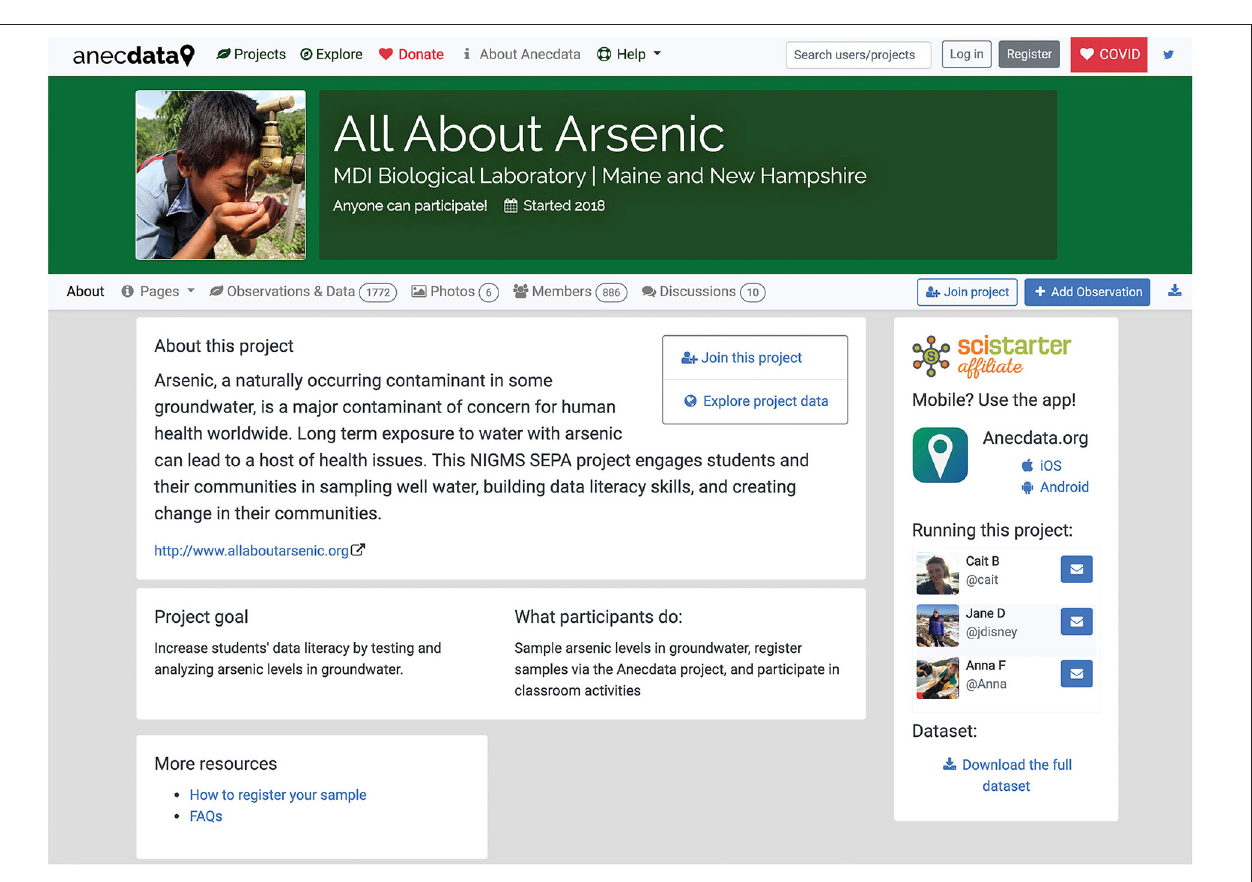
Frontiers in Climate |